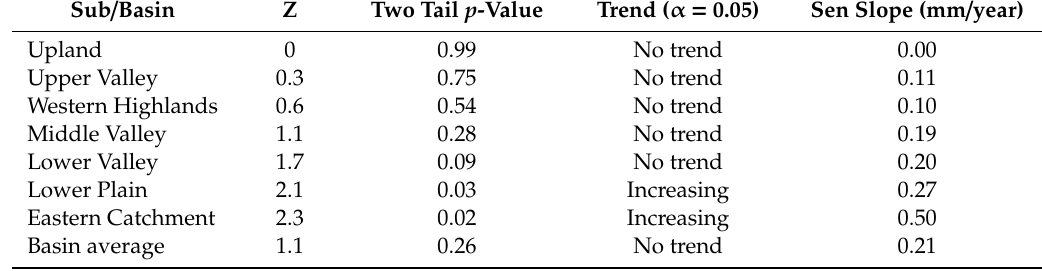
Table 5. Summary trend analysis for autumn season rainfall.